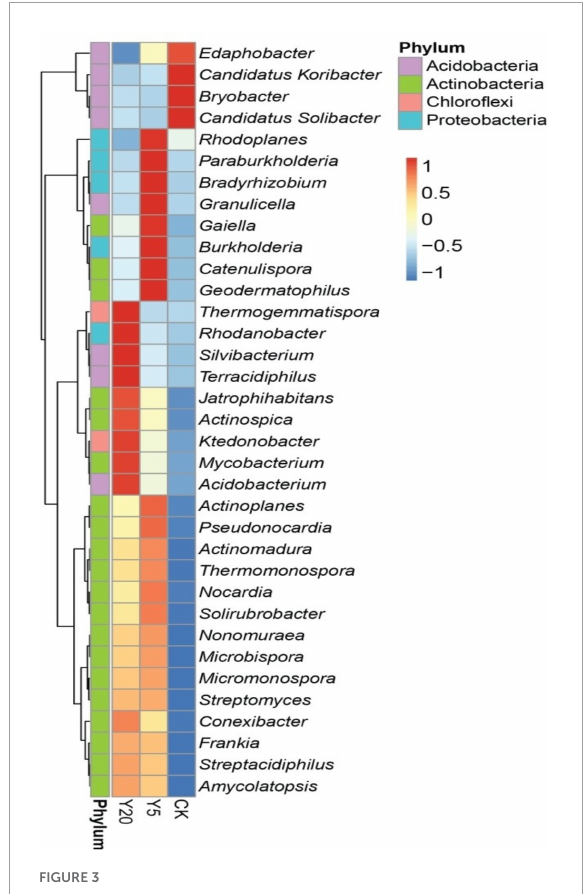
FIGURE3 A heat map showing the top 35 most abundant genera through using normalized abundance in each M. integrifolia rhizosphere treatment group ( CK = 1-year monoculture orchard, Y5 = 5-year monoculture orchard, and Y20 = 20-year monoculture orchard). The color codes are based on